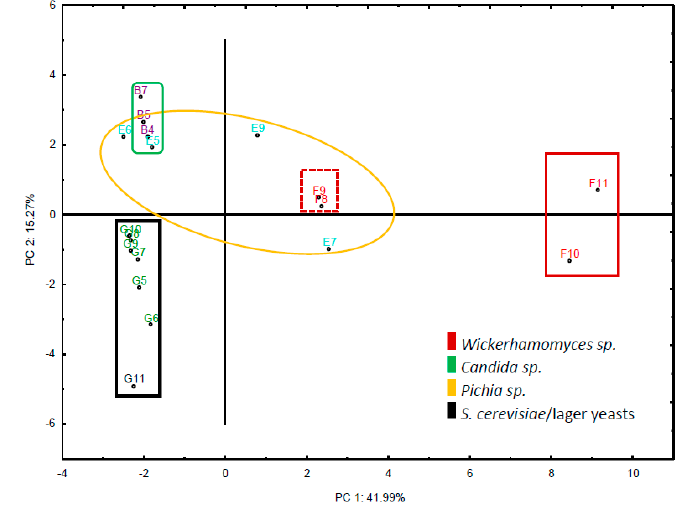
Figure 2 . Principal component analysis of the set of selected strains and their chemical compounds produced. The matrix is based on the set of 19 strains and the VOCs detected. Strains are presented with their assigned coordinates (see Table 1). Species belonging to the same genus are represented by the same color.